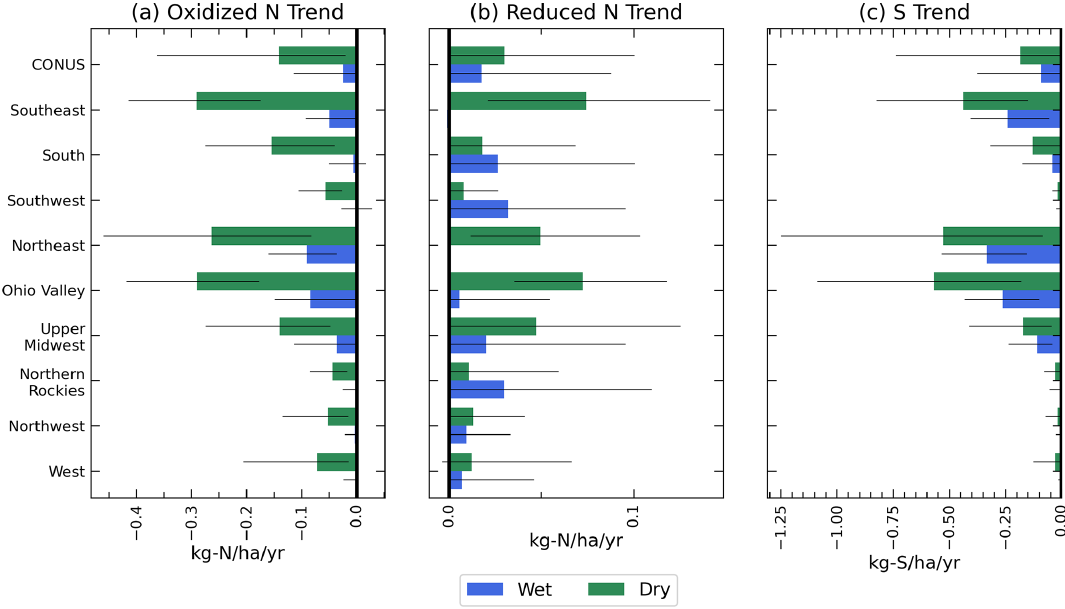
Figure 8. Annual average trend (2002–2017, kgha − 1 yr − 1 ) of wet (blue) and dry (green) oxidized nitrogen (a) , reduced nitrogen (b) , and sulfur (c) deposition throughout the CONUS and nine climate regions. Whiskers extend to the 5th and 95th percentiles of the trends.